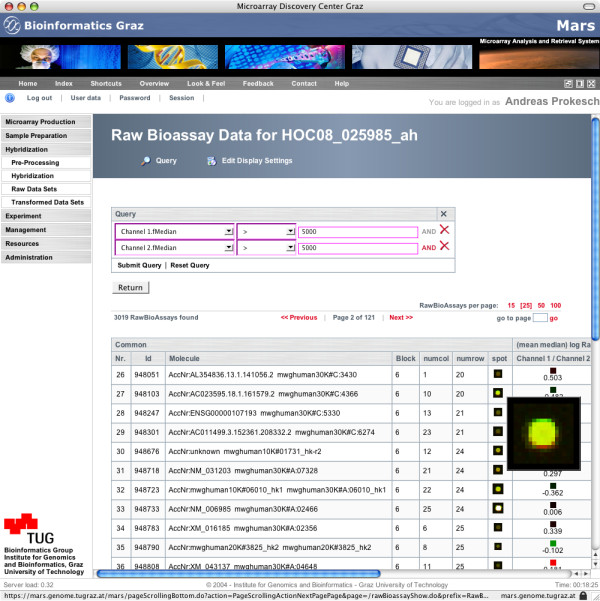
Typical MARS interface listing stored records. It allows to query for specific records using the user friendly query tool.